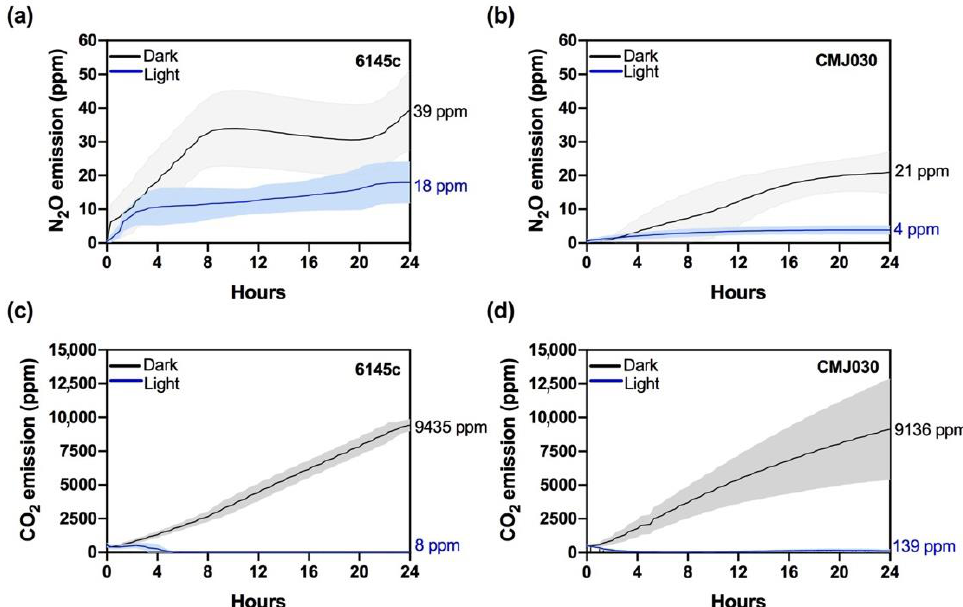
Figure 5. N 2 O and CO 2 emissions in the wild-type strain 6145c and the nit1nit 2 mutant CMJ030. NH 4+ -grown cells were washed and transferred to 10 mM NO 2 − -containing media in sealed bottles in the light (blue line) or the dark (black line). N 2 O emissions ( a , b ) and CO 2 ( c , d ) were quantified during 24 h. Each data line represents an average of three biological replicates, and the colored area corresponds to ±SD.